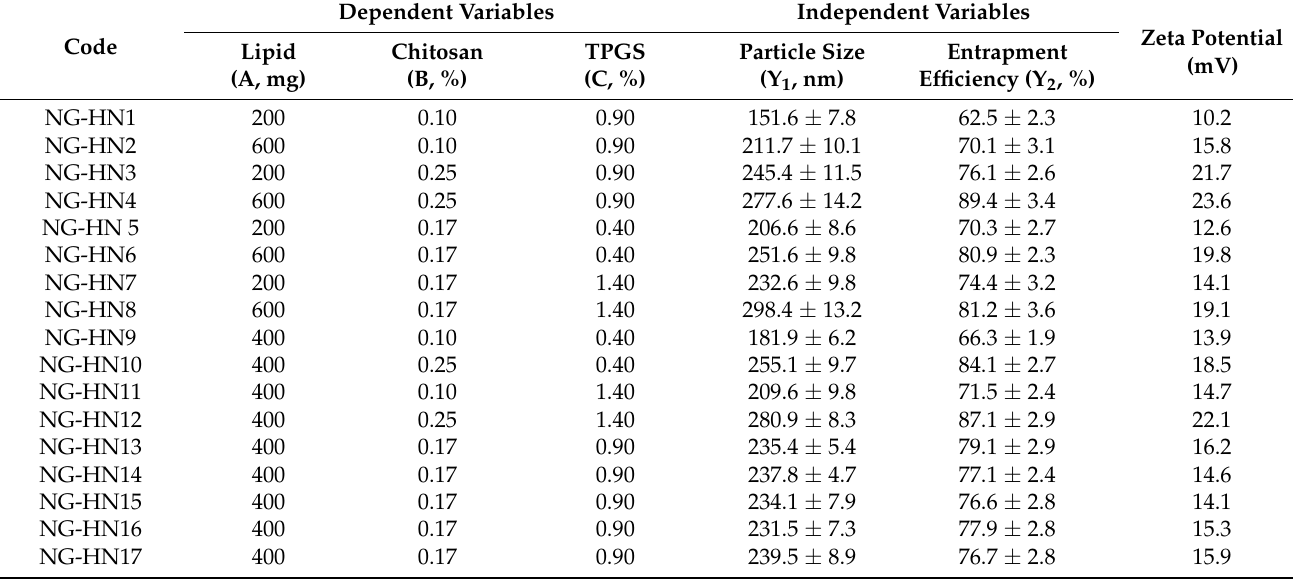
Table 2. Composition of Naringin hybrid nanoparticles (NG-HNs) with their experimental